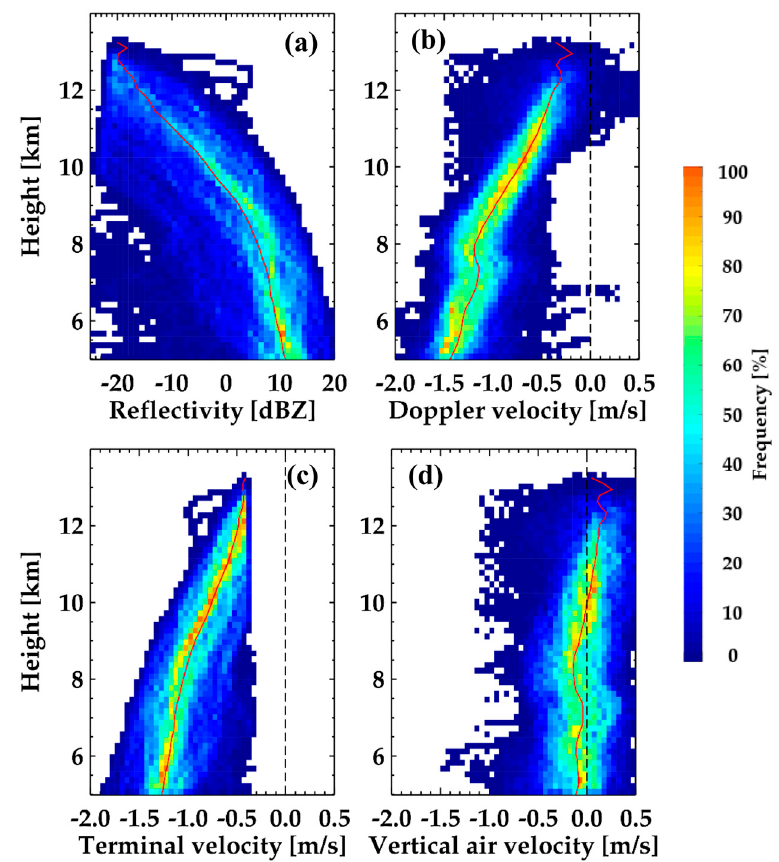
Figure 17. CFADs of ( a ) reflectivity, ( b ) Doppler velocity, ( c ) terminal velocity, and ( d ) vertical air velocity for a RainDP case on 5 July, 2014. The median is shown in the red line.